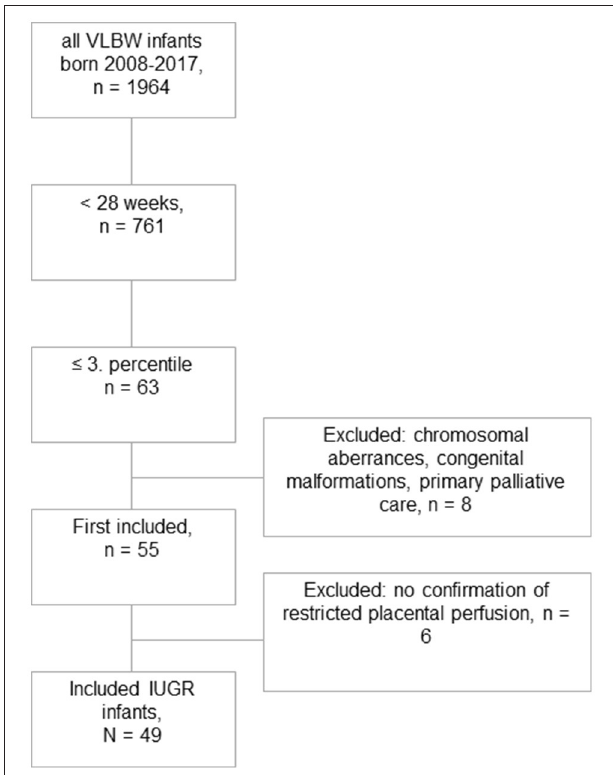
FIGURE 1 | Flowchart of this retrospective case–control study. Out of 1,964 very low birth weight born infants during the study period, 49 could finally be included with severe IUGR ≤ 3rd percentile and evidence of uteroplacental dysfunction.